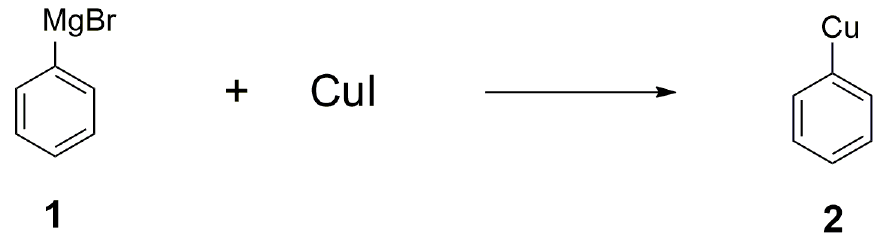
Figure 1. Phenyl copper prepared from phenyl magnesium bromide.